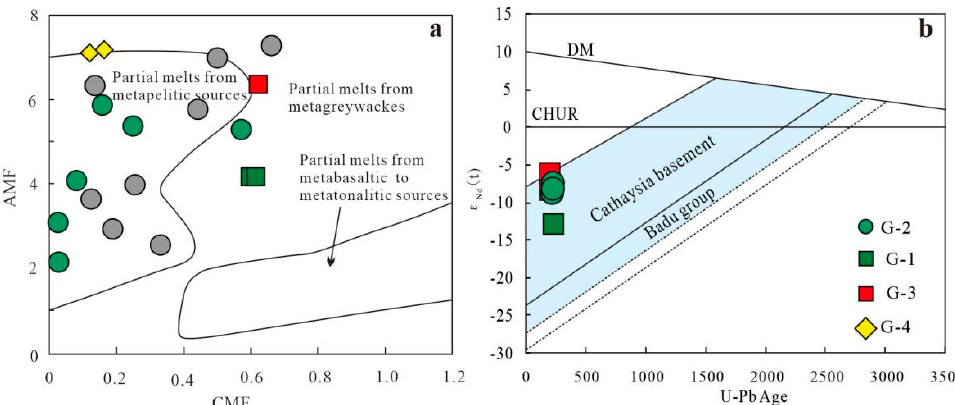
Figure 15. ( a ) AMF versus CMF diagrams, ( b ) ε Nd (t) versus formation age